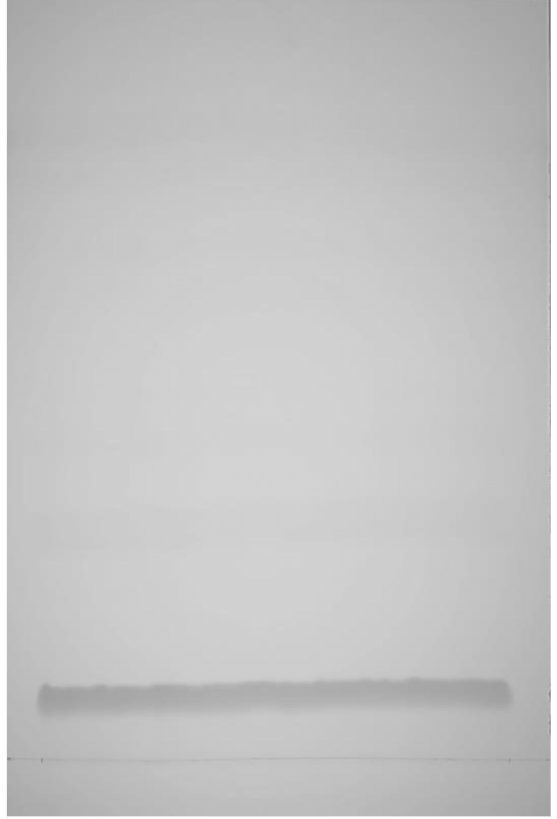
Figure 7. Preparative TLC chromatogram of α